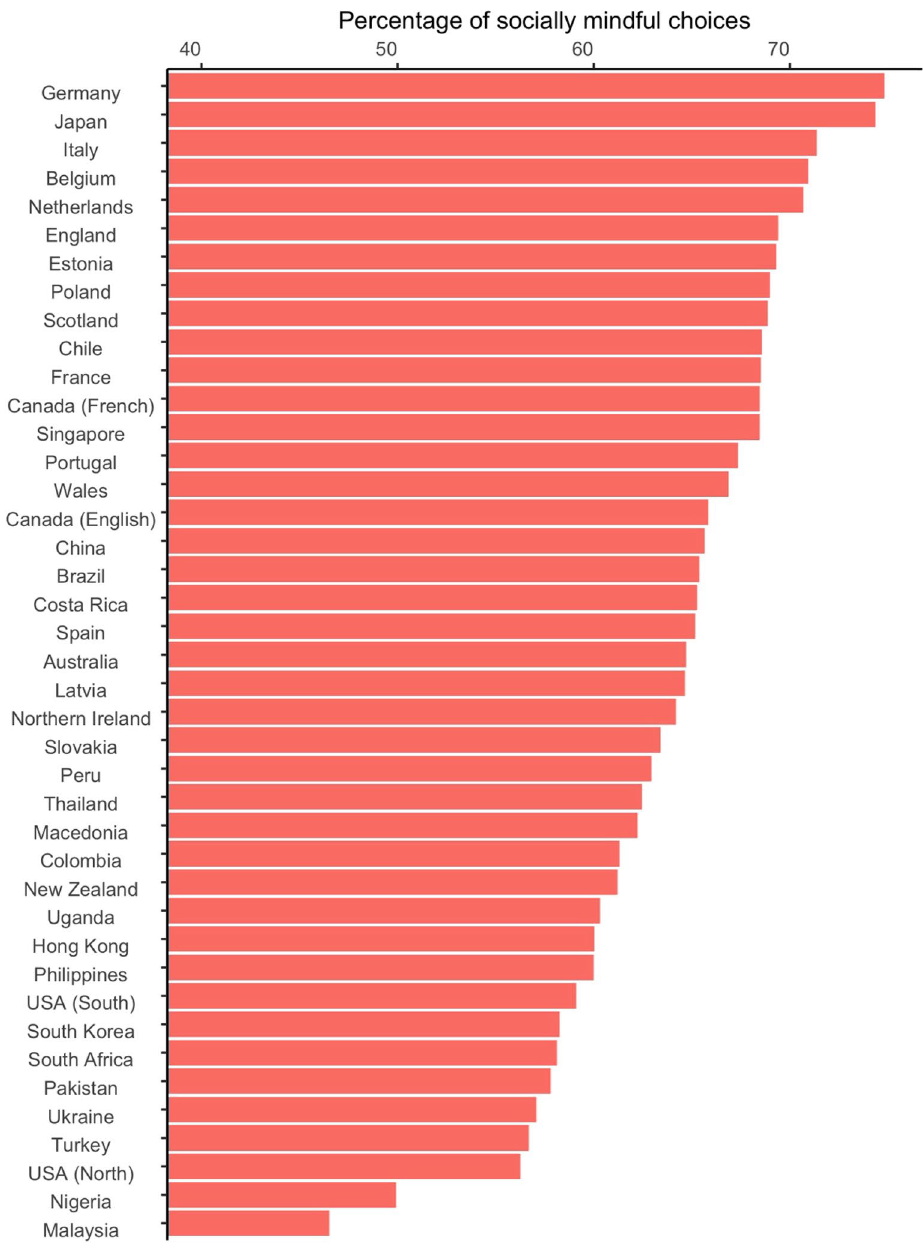
Figure 1. Average percentage of socially mindful choices per